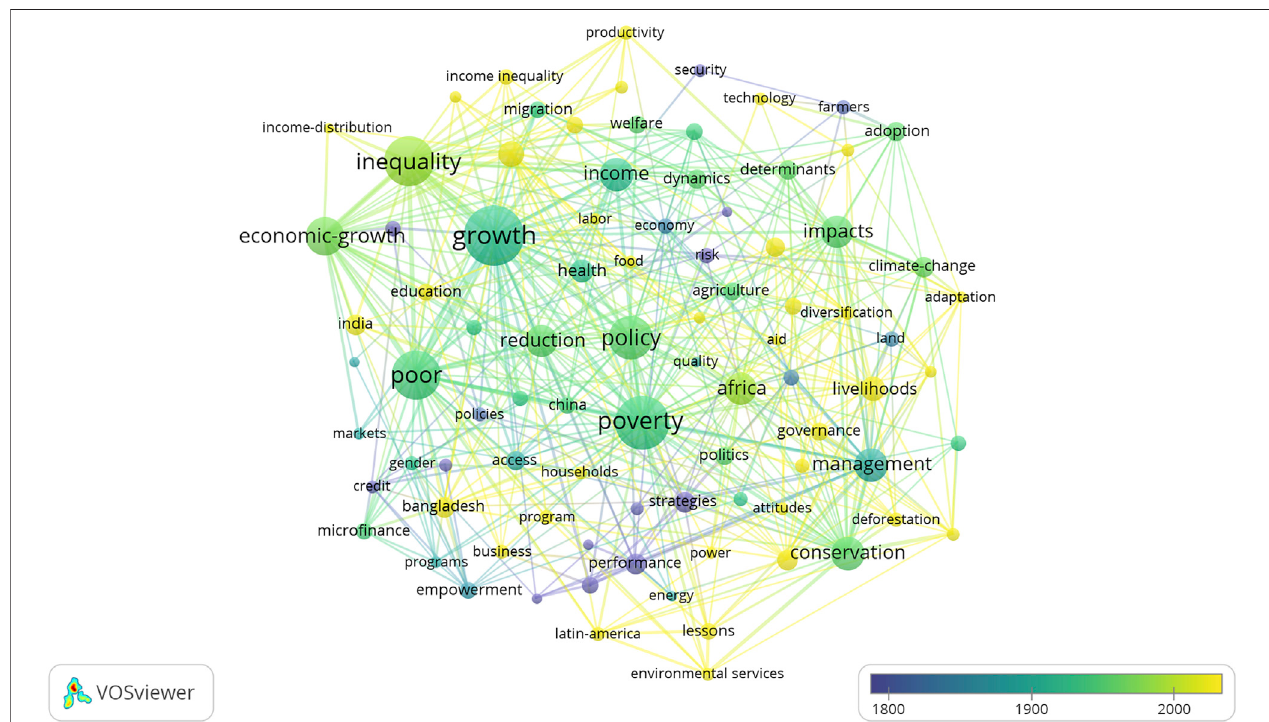
FIGURE 9 | Keywords-plus co-occurrence time trend map.